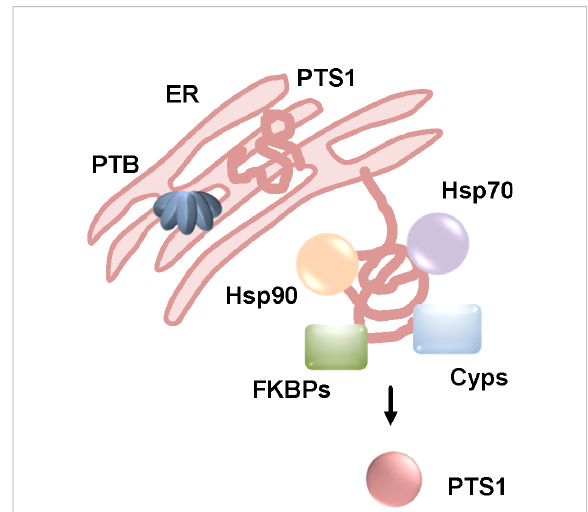
FIGURE 7 The activity of Hsp90, Hsp70, Cyps and FKBPs is required to the uptake of PTS1 into cells. After receptor-mediated endocytosis, PT is transported through the Golgi to the ER where PTS1 is released from the B-oligomer (PTB). This leads to unfolding of PTS1 due to thermal instability. Unfolded PTS1 is transported into the cytosol by the ER-associated degradation pathway. Upon inhibition of Hsp90, Hsp70, Cyps and FKBPs, intoxication of cells by PT is reduced, less PTS1 is detected in cells. For inhibition of Hsp90 and Cyps it was shown that less PTS1 molecules reach the cytosol suggesting that assistance of PTS1-translocation from the ER to the cytosol by chaperones and PPIases is the common underlying mechanism (Ernst et al., 2018a; Kellner et al., 2019; Ernst et al., 2021a; Kellner et al., 2021). (FKBPs, FK506 binding proteins; Cyps,